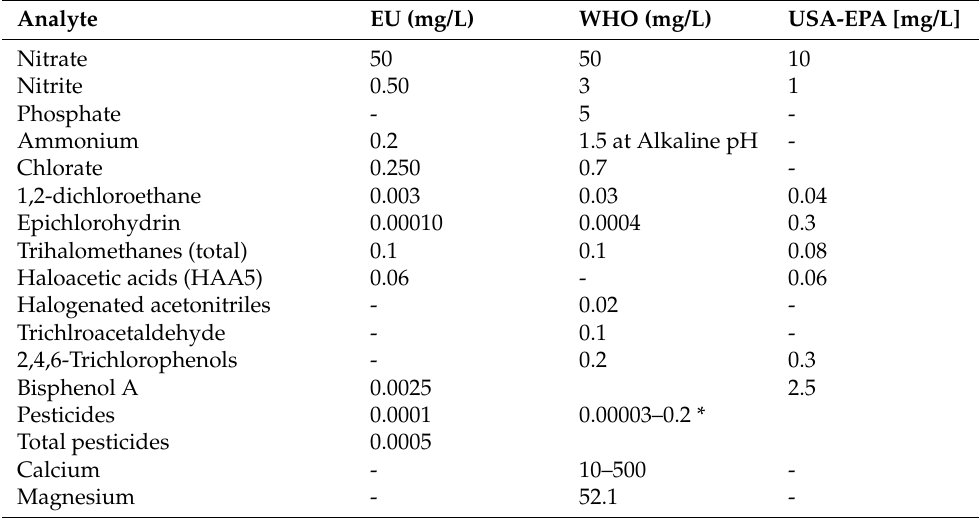
Table 1. Maximum allowable concentration for water quality assessment for EU [19], WHO [20] and USA-EPA